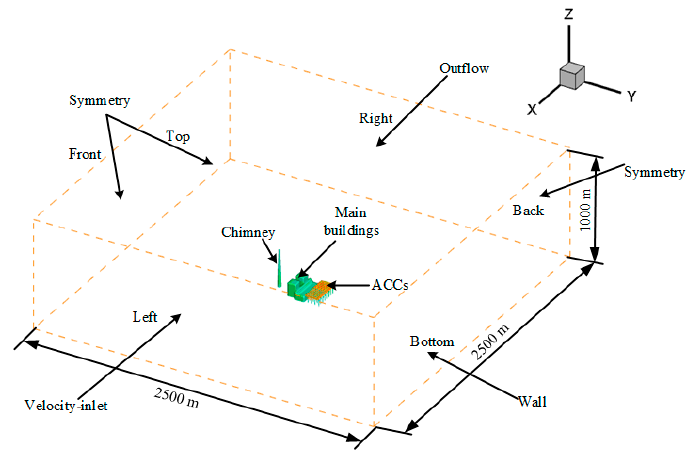
Figure 3. Computational domain and boundary conditions.